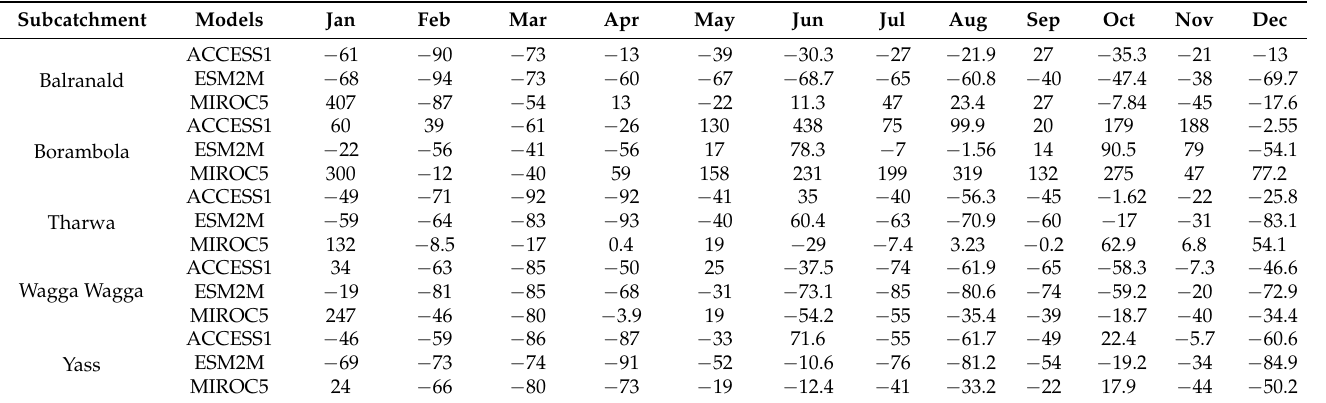
Table 6. Change (%) of runoff between simulated (using future climate data) compared to the historical for RCP 8.5 at the sub-catchments of Murrumbidgee River